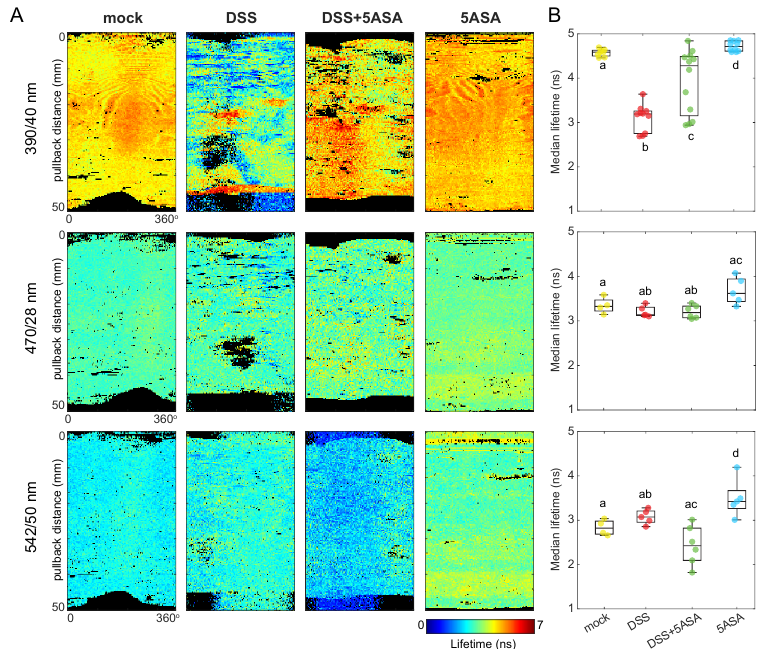
Figure 3. ( A ) Representative fluorescence lifetime maps for each treatment group in every spectral band used for this study. Images were acquired intraluminally and are shown here as flat 2D maps of the luminal surface from the proximal (top) to the distal (bottom) ends of the colon for ease of interpretation. Black pixels indicate outliers (lifetime below 0.25 percentile or above 0.75 percentile). ( B ) Median average fluorescence lifetime from each imaged colon for each condition and spectral band. Pairwise Mann–Whitney U test was applied to test statistical differences between groups.